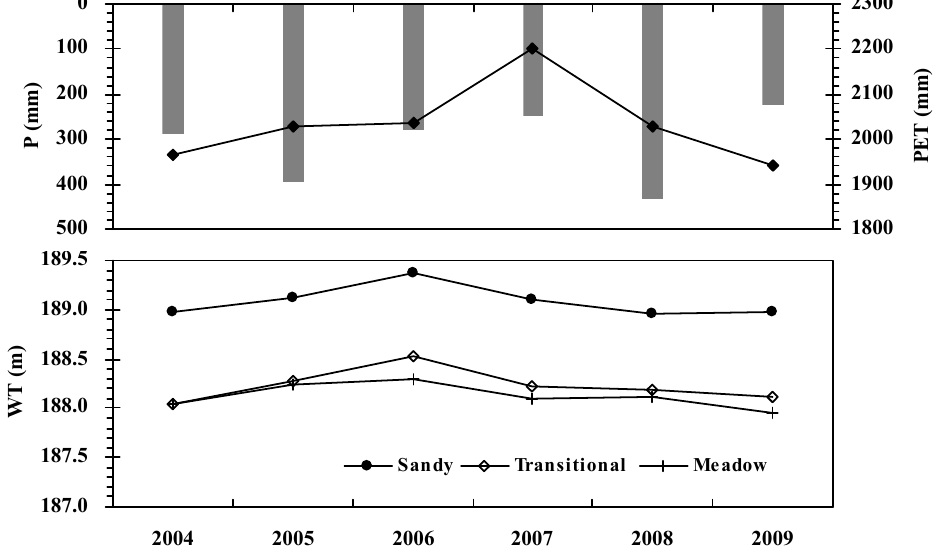
Figure 3. Responses of mean annual water table (WT) to cumulative annual precipitation (P) and potential evapotranspiration (PET) for the three land cover types in the study area. The average ground elevation is 212.0 m for the sandy areas (Sandy), 190.0 m for the transitional zones (Transitional), and 188.5 m for the meadowlands